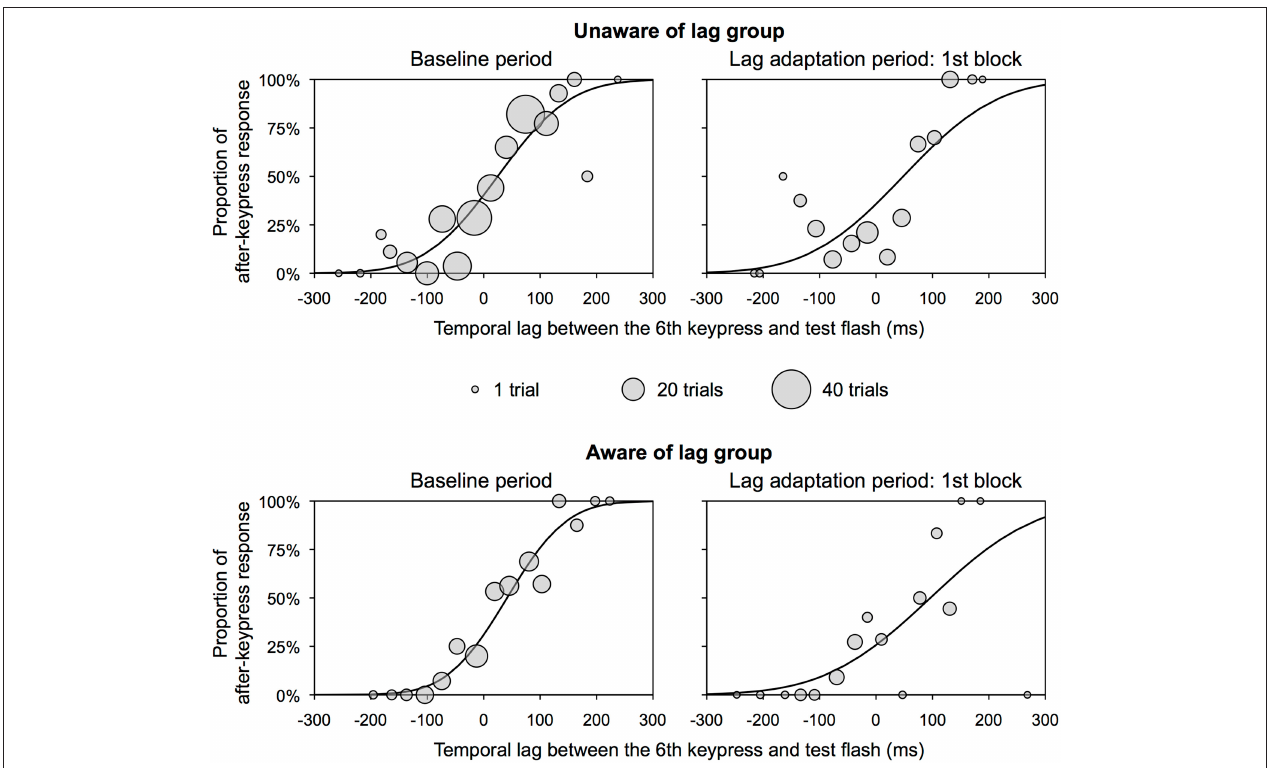
FIGURE 4 | Representative psychometric function for each group in Experiment 2. These functions were obtained by the use of all observers’ data. Circles show the proportion of after-keypress response in each bin. Circle size shows the number of trials in each bin. A temporal lag between the sixth keypress and test flash on x -axis does not contain any inevitable delay due to a computer system.